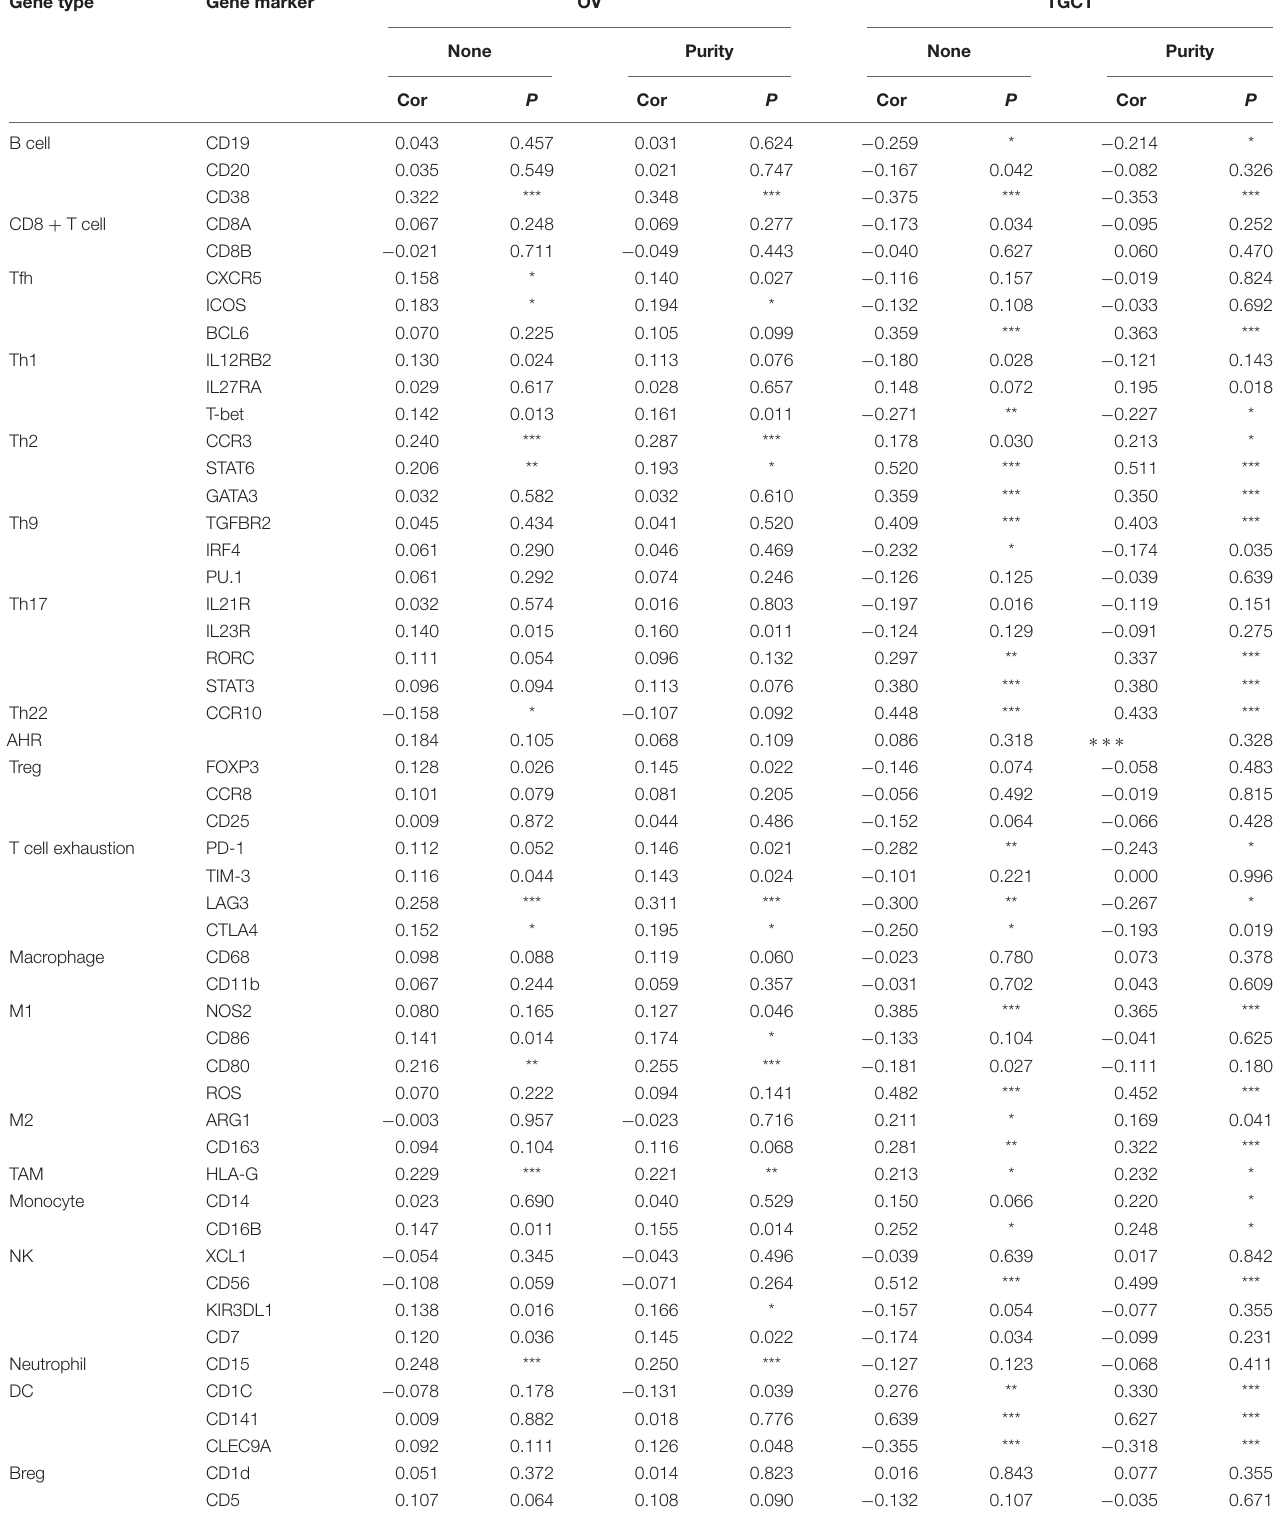
TABLE 3 | Correlations between ACE2 and gene markers of immune cells in OV and TGCT. Gene type Gene